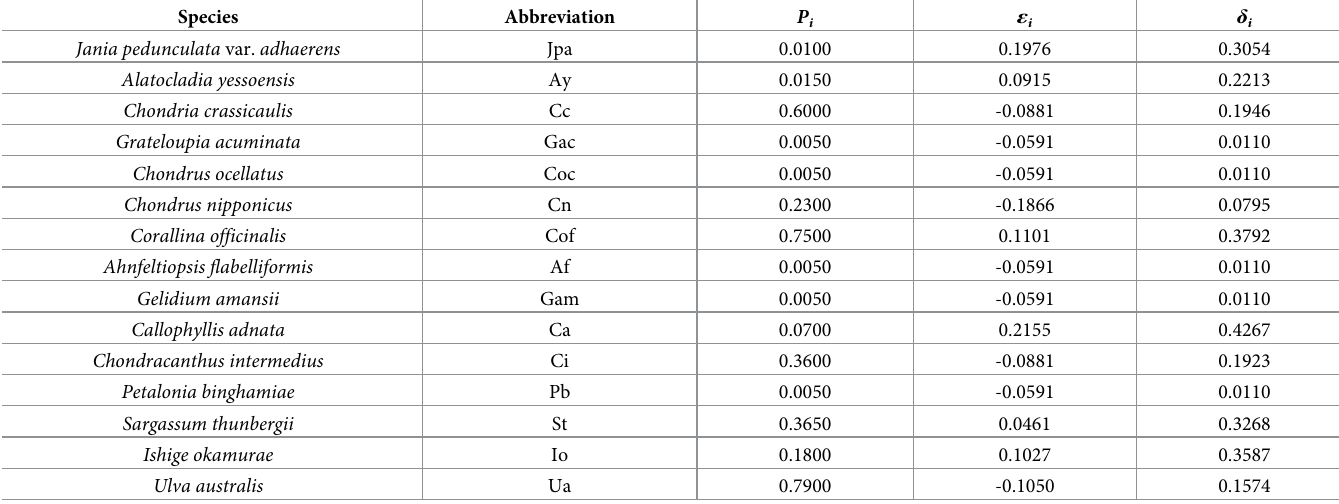
Table 1. Identified macroalgae species and their spatial